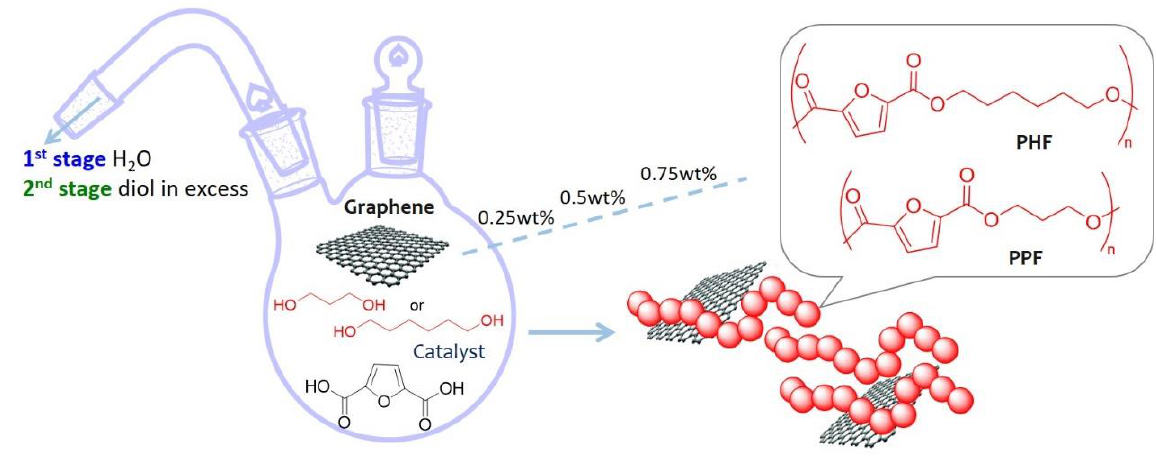
Figure 1. General scheme of synthesis of PPF or PHF graphene composites.